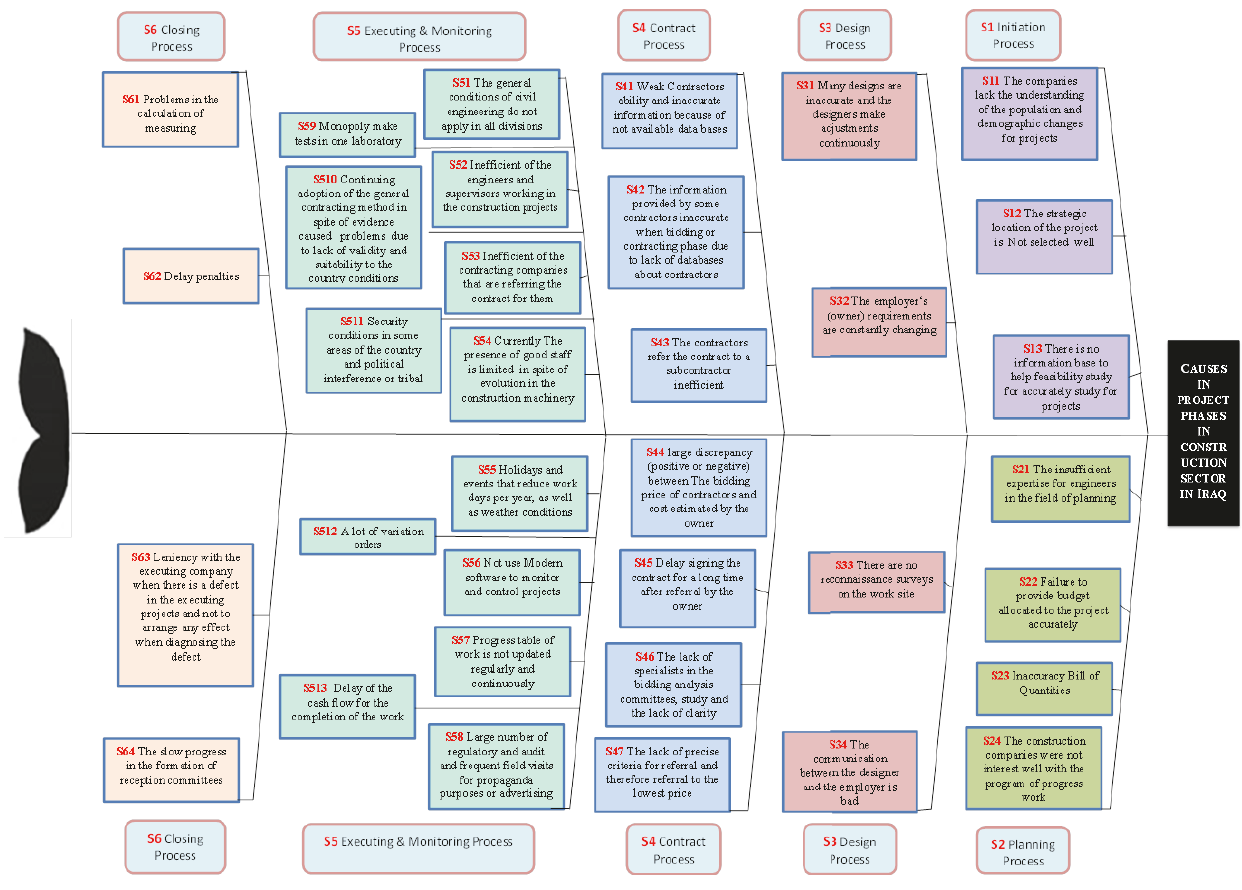
Figure 1: Ishikawa diagrams.